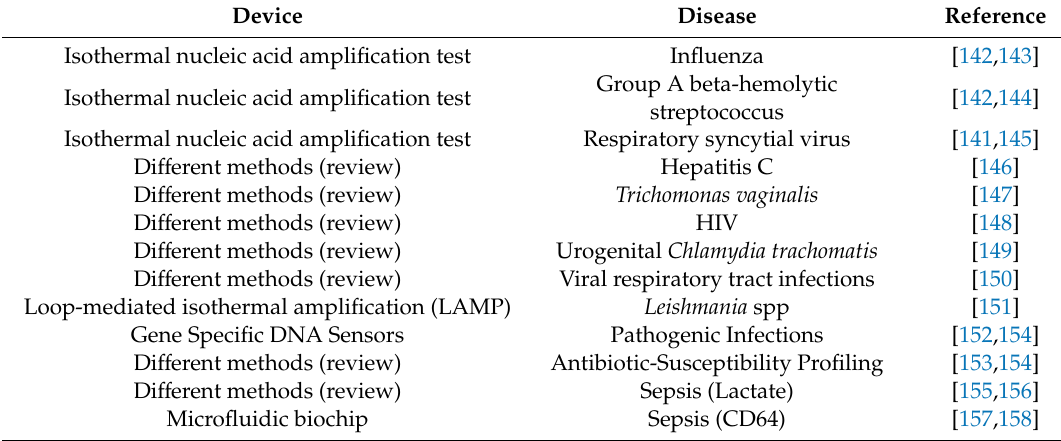
Table 2. Clinical application in infectious